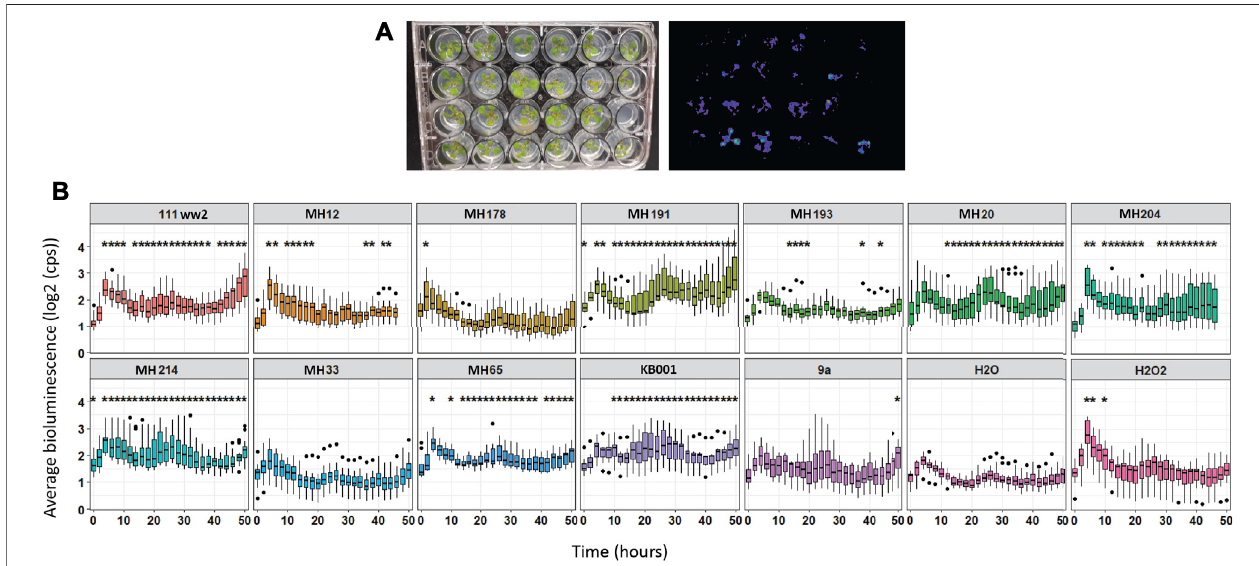
FIGURE 2 | Screening of Actinobacteria to identify candidates with potential for biocontrol. Arabidopsis seedlings were grown on MS media in 24-well plates for 10 days. Spores of Actinobacteria were added around the roots of seedlings, and GSTF7:luc luminescence was measured hourly over 50 h. Water and 1 mM H 2 O 2 treatmentswereaddedtoplantsasreferences.Averagewascalculatedoutof12biologicalreplicates.Dotsrefertooutliersamples.A t -testwasperformedtodetermine signi fi cant differences between samples compared to water treatment. * p < 0.05.